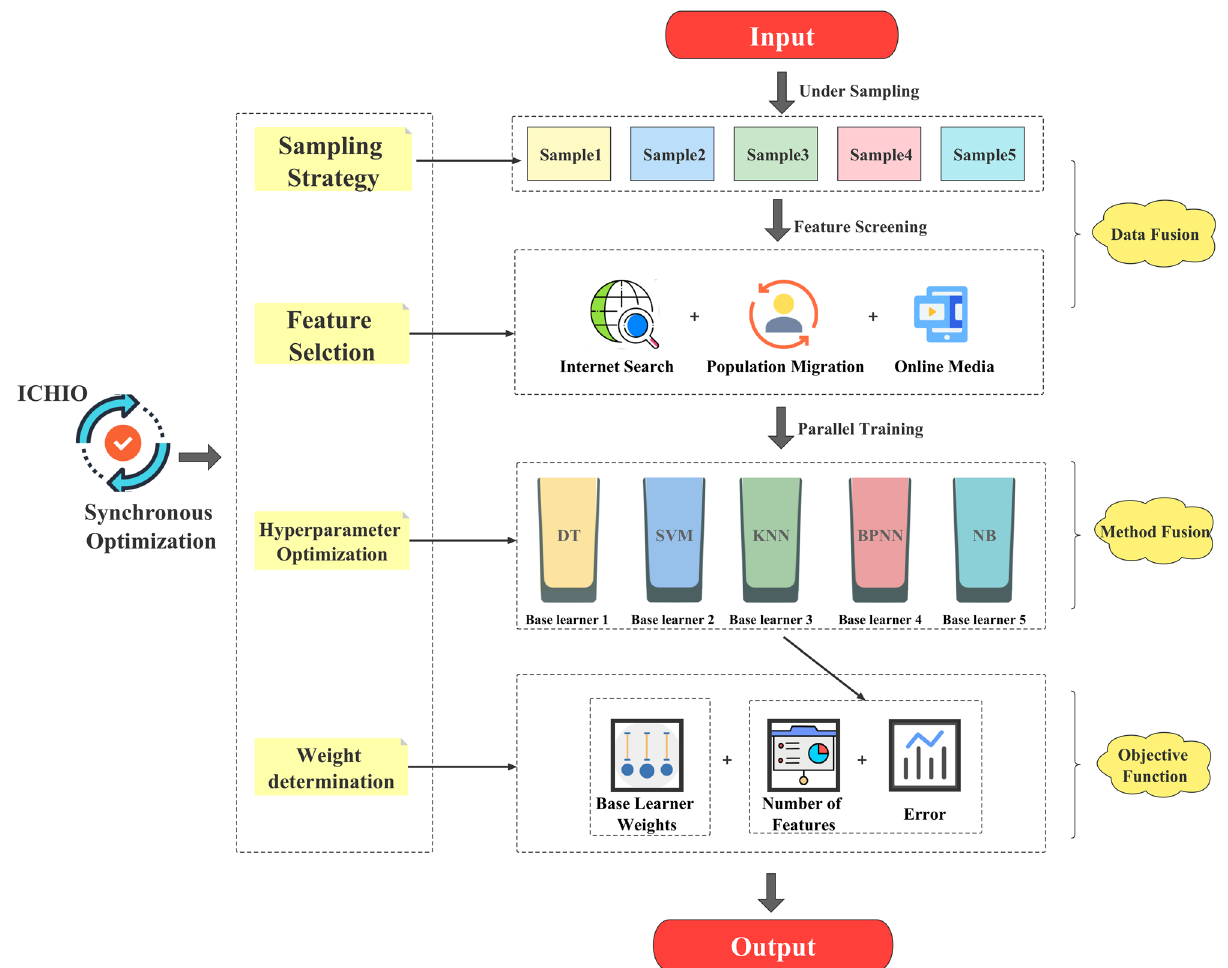
Fig. 14 The structure of the USEE model. DT Decision Tree, SVM Support Vector Machine, KNN K-Nearest Neighbour, BPNN BP Neural Network, NB Naive